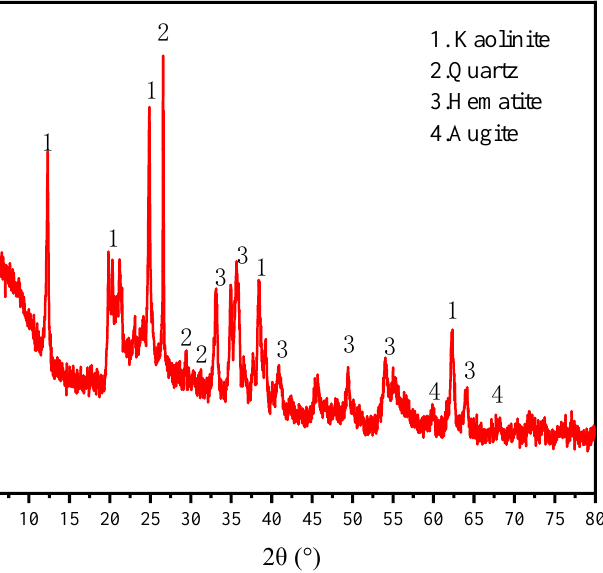
Figure 2. XRD pattern of BP. Phase identified: Kaolinite, Al 4 (OH) 8 (Si 4 O 10 ), PDF No. 78-2109; Quartz, SiO 2 , PDF No. 79-1906; Hematite, Fe 2 O 3 , PDF No. 72-0469; Augite, FeO, PDF No. 46-1312.